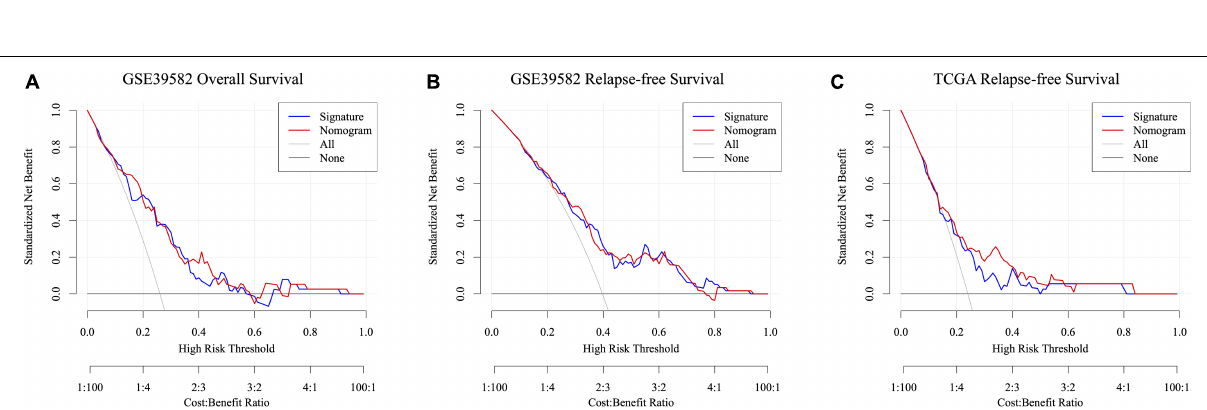
Frontiers in Oncology |